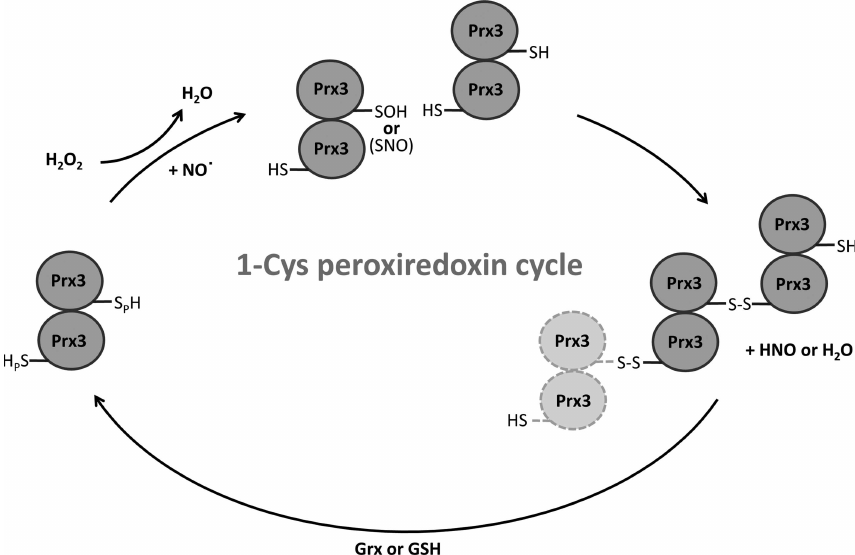
Figure 7 Proposed catalytic cycle of 1-Cys Vv Prx3. Each Prx3 polypeptide is represented by grey circles, with the peroxidatic Cys48 highlighted according to its redox state: sulfhydryl, –SH; sulfenic acid, –SOH; nitrosothiol, –SNO; disulfide, –S—S–. Potential conformations of additional dimers are indicated by light grey